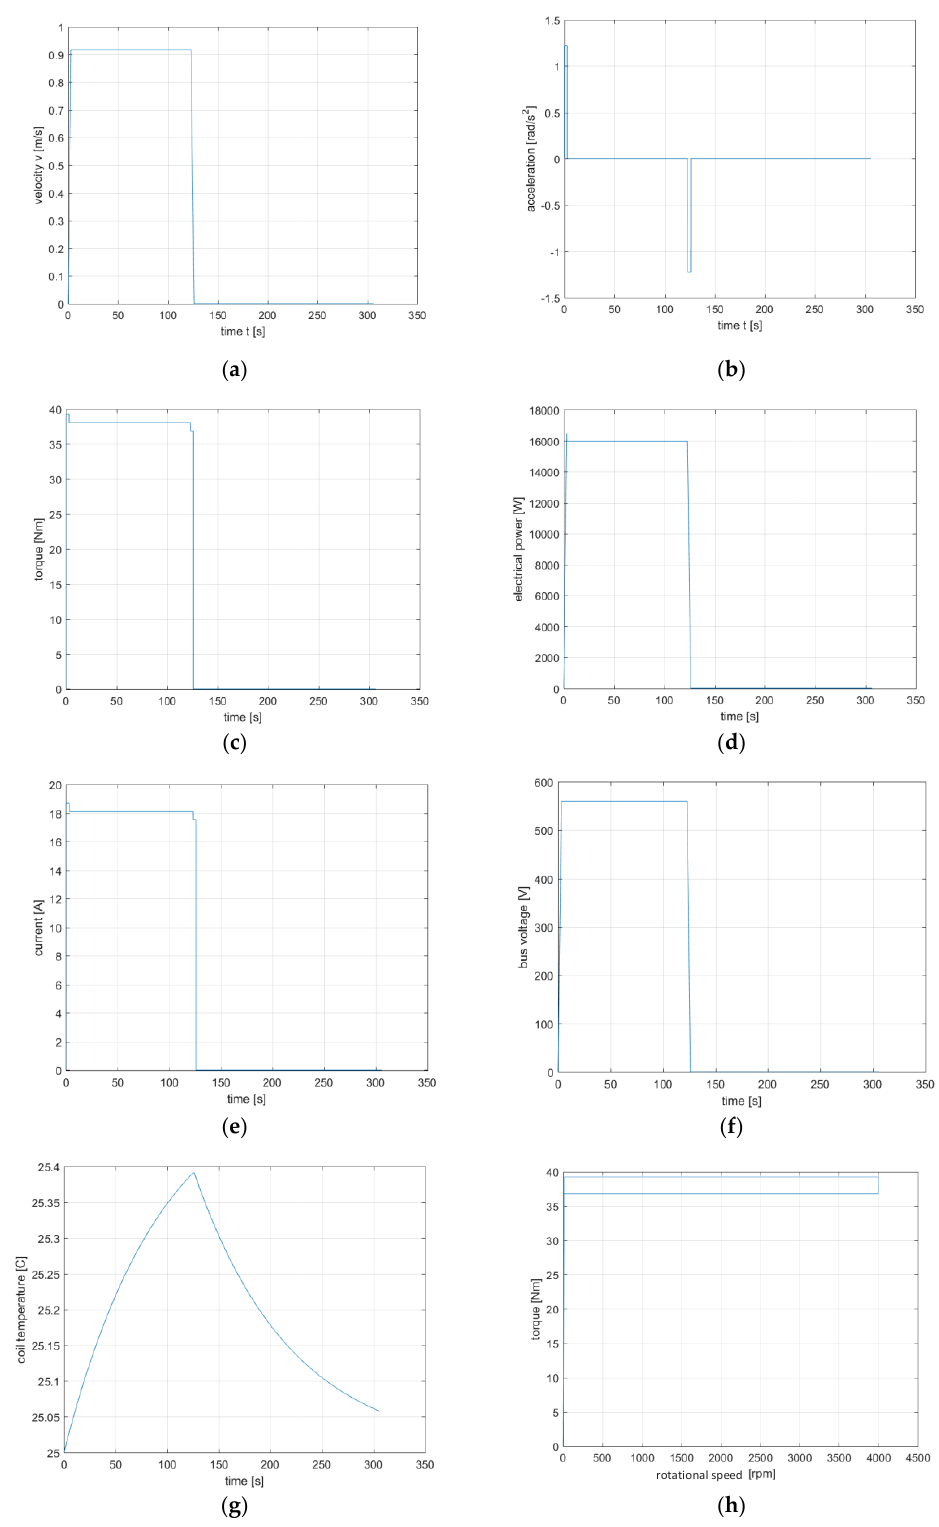
Figure 10. The work cycle of the main electric drive of the tower crane: ( a ) velocity waveform, ( b ) acceleration waveform, ( c ) torque waveform, ( d ) electrical power waveform, ( e ) current waveform, ( f ) bus-voltage waveform, ( g ) motor coil temperature, ( h ) mechanical